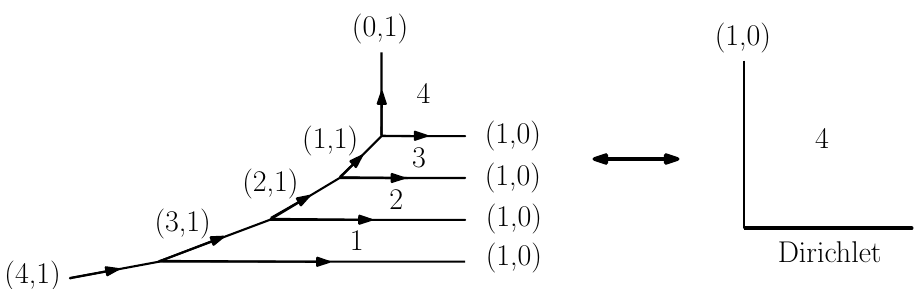
Figure 11. Con(cid:12)guration corresponding to U(4) (cid:9) Kac-Moody